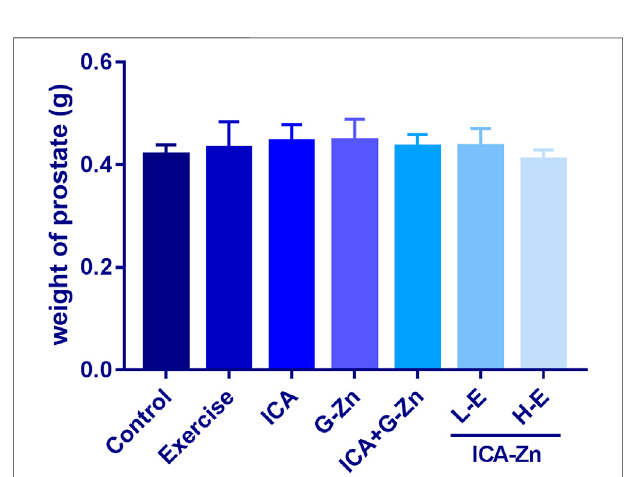
FIGURE 10 | Effect of icariin zinc on the weight of the prostate gland in rats ( n (cid:2) 8, mean ± SD).